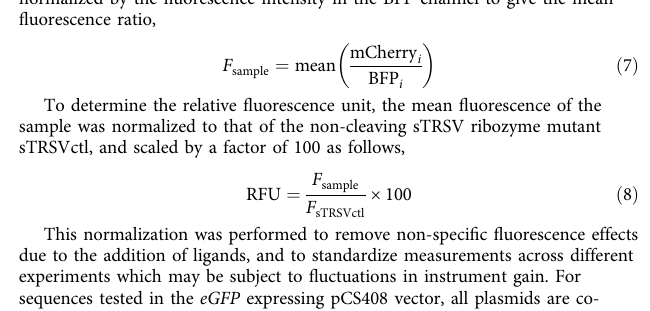
Table 8). All DNA templates for control ribozymes have the architecture 5 ′ - AAACAAACAAAGCTGTCACCGGA <loop I>